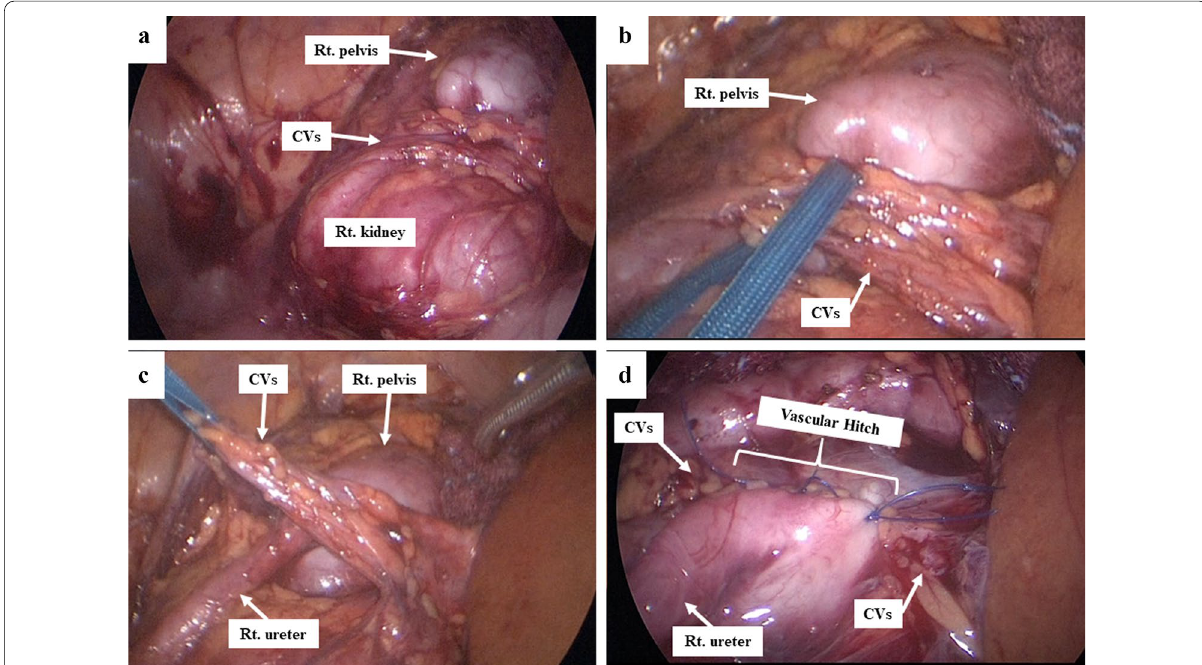
Fig. 4 Operative findings and procedures. a dilated pelvis and CVs, b dissection of CVs, c taping of CVs and intraoperative DT with furosemide loading, d vascular hitch